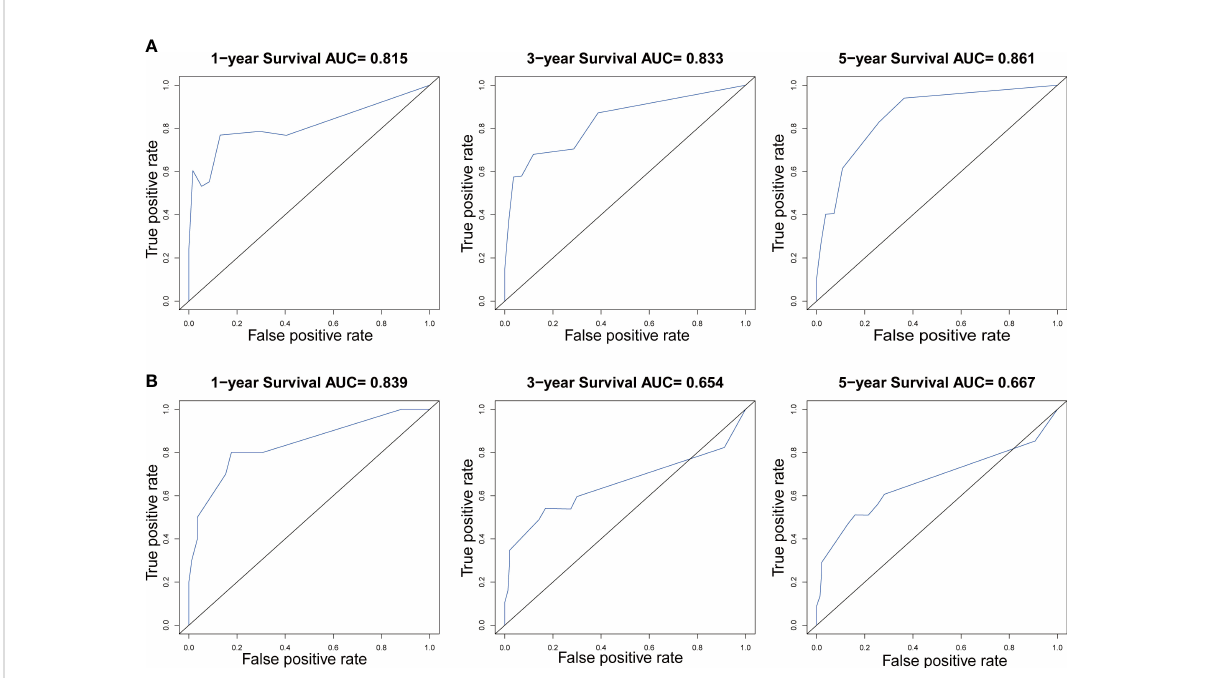
FIGURE 6 The ROC curves of the nomogram predicting 1-year, 3-year, and 5-year (A) CSS and (B) OS in the training cohort.